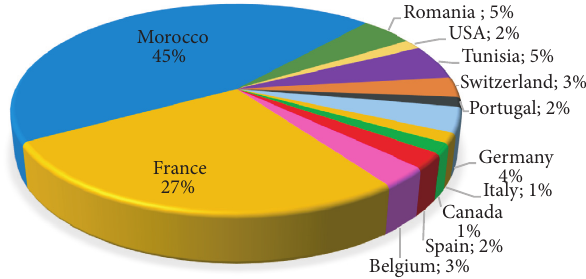
Figure 7: Countries of the participating companies.